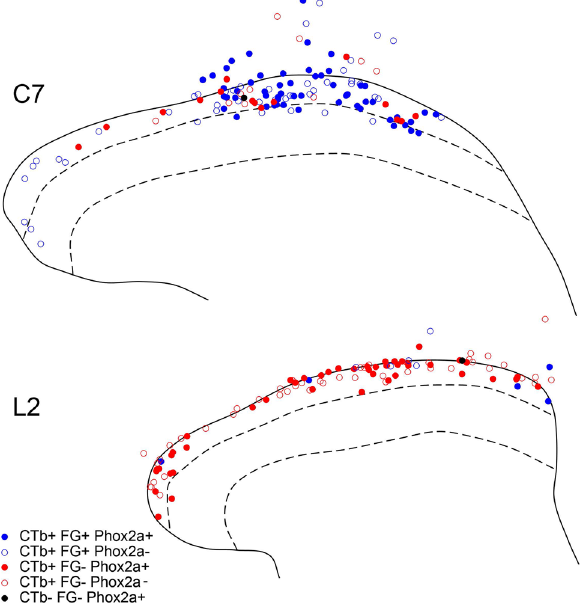
Figure 3. Plots showing the distribution of retrogradely-labelled and tdTomato-positive cells in the C7 and L2 segments from experiment #6, in which injections of cholera toxin B subunit (CTb) and Fluorogold (FG) were targeted on the lateral parabrachial area and thalamus, respectively. tdTomato-positive and -negative cells are shown with solid and open symbols, respectively. Those that were retrogradely labelled with CTb and FG are shown in blue, and those labelled only with CTb in red. Only one tdTom cell (in the L2 segment) was not retrogradely labelled, and this is shown in black. Dashed lines represent the dorsal and ventral borders of lamina II. Outline drawings were prepared with XaraXtreme v2 (http:// www. xarax treme. org/).